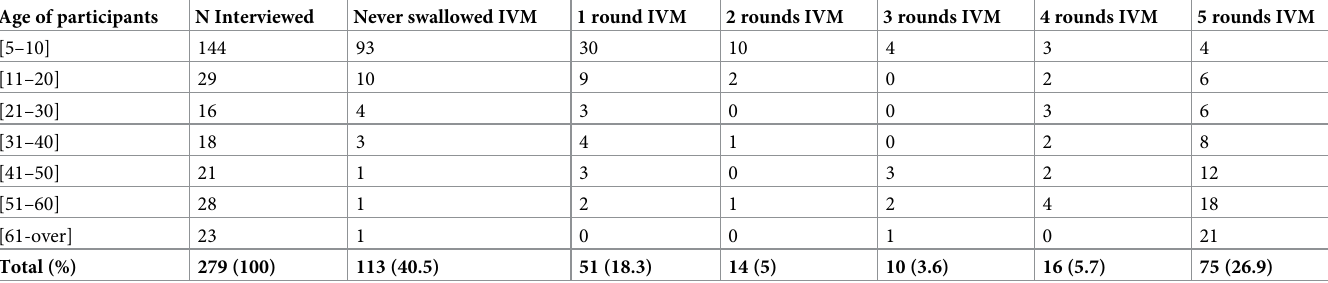
Table 1. History of IVM intake for the last five years according to age classes.